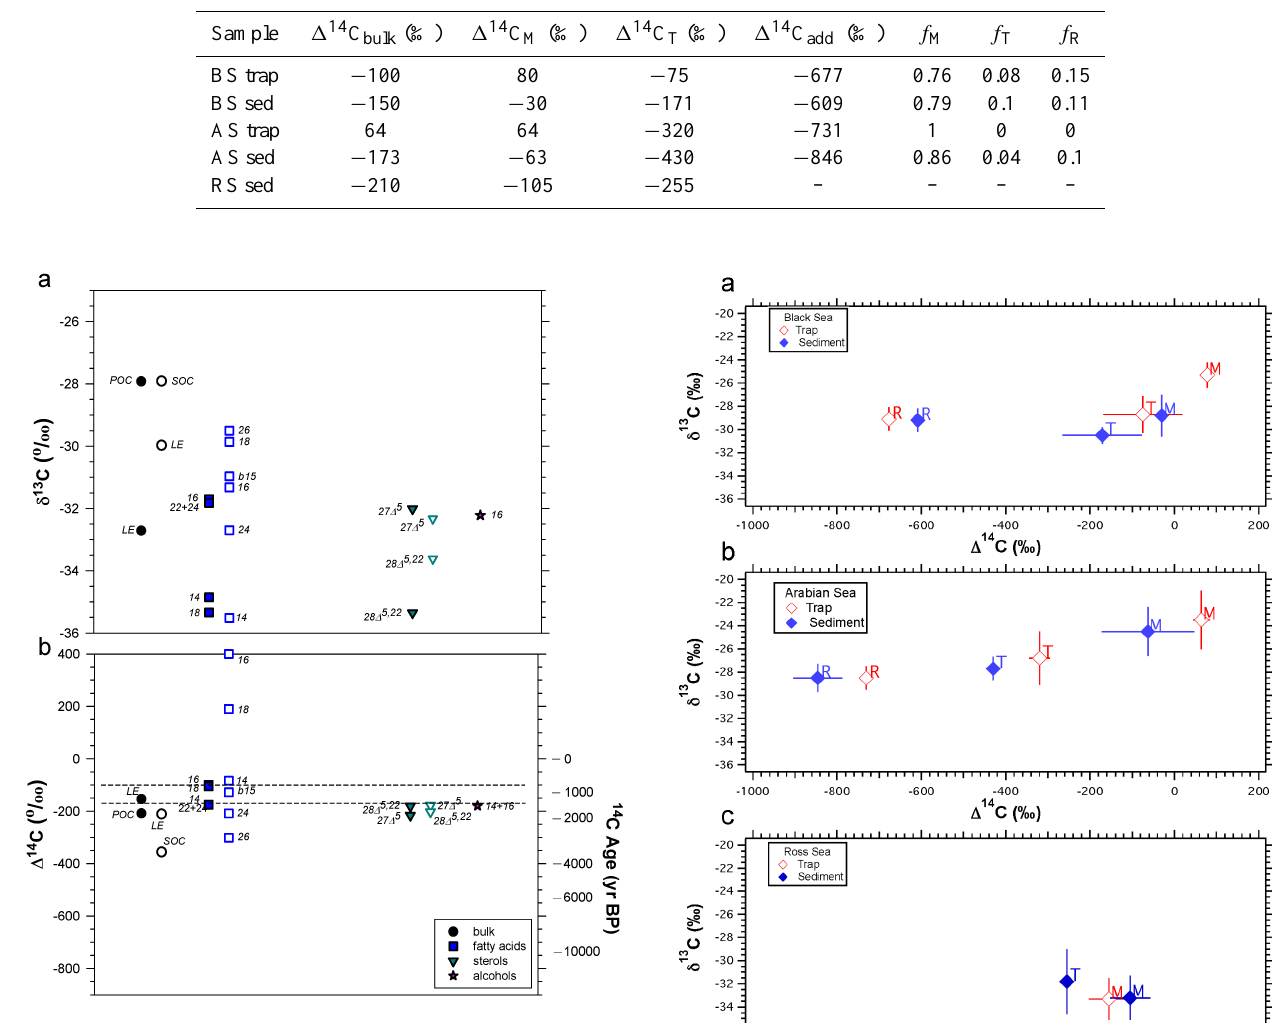
Figure 10. The (a) δ 13 C and (b) (cid:49) 14 C values of bulk POC and SOC and individual biomarkers for trap and sediments from the Ross Sea (see also Table 3). Filled symbols are trap biomarkers; open symbols are sediment biomarkers. All values have been cor- rected for procedural blanks and any derivative carbon, as needed. Dashed lines are pre-bomb (lower) and post-bomb (upper) mixed- layer (cid:49) 14 C DIC .